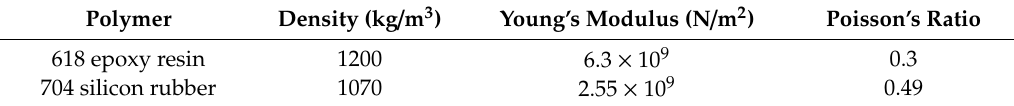
Table 2. Parameters of